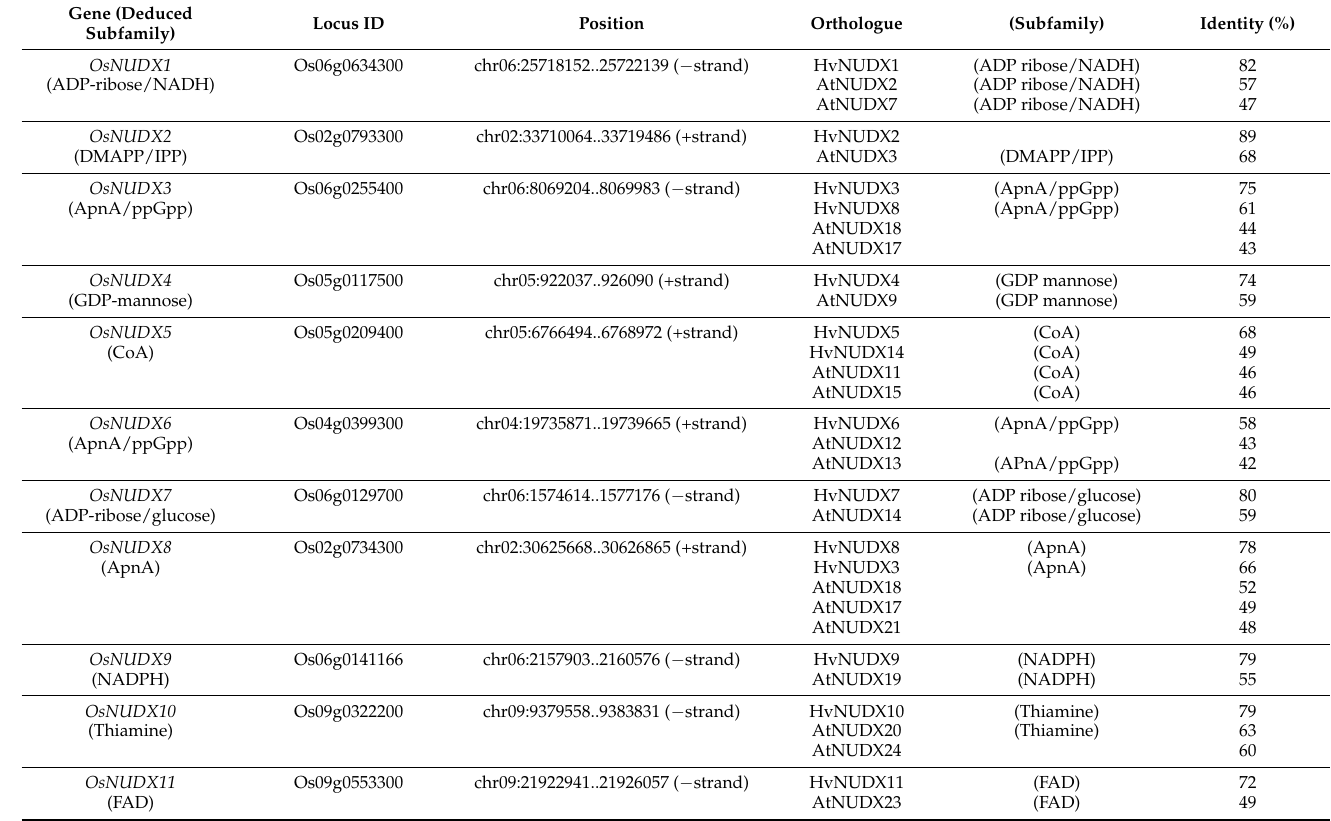
Table 1. Putative NUDX genes in the rice genome and identification of OsNUDX genes with those of HvNUDX and AtNUDX